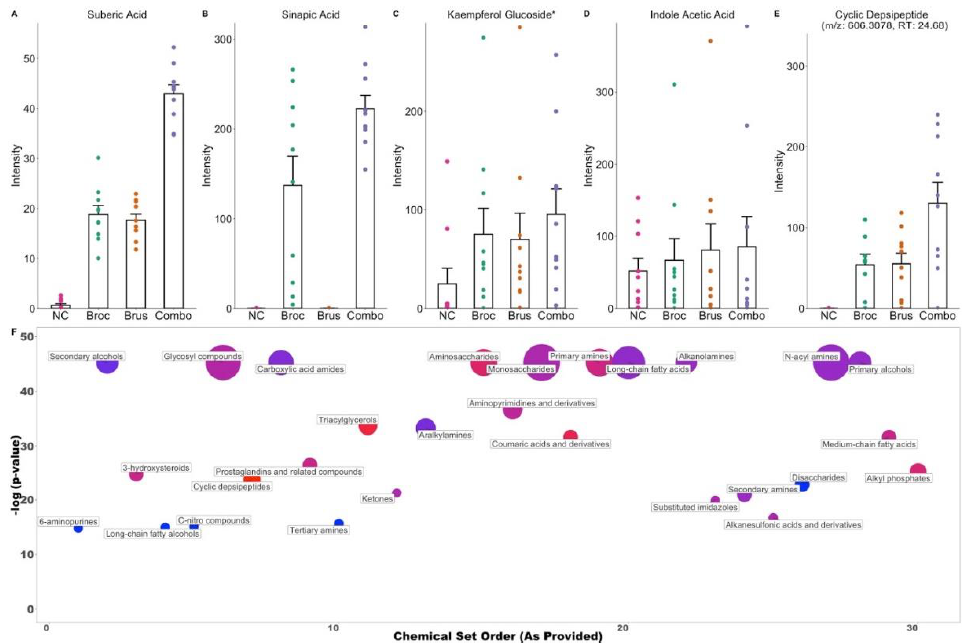
Figure 3. Cruciferous vegetable exposure leads to an increase in plant- and microbial-derived metabolites: ( A – E ) Intensity of metabolites in each group, as detected by LC-MS/MS. Each point represents an individual, bars represent means, and error bars show standard error. Metabolite identity of ( A – D ) confirmed via MS/MS fragmentation pattern matching. ( E ) Predicted via de novo annotation. ( F ) Chemical Enrichment Analysis (ChemRICH) impact plot for NC vs. Combo. The size of each cluster represents the number of metabolites belonging to it, and the y-axis shows the level of significance; the color of the dot refers to if the compounds were increased (red) or decreased (blue) in Combo relative to NC. Only significant clusters are shown, and peptides and amino acids have been removed for clarity.